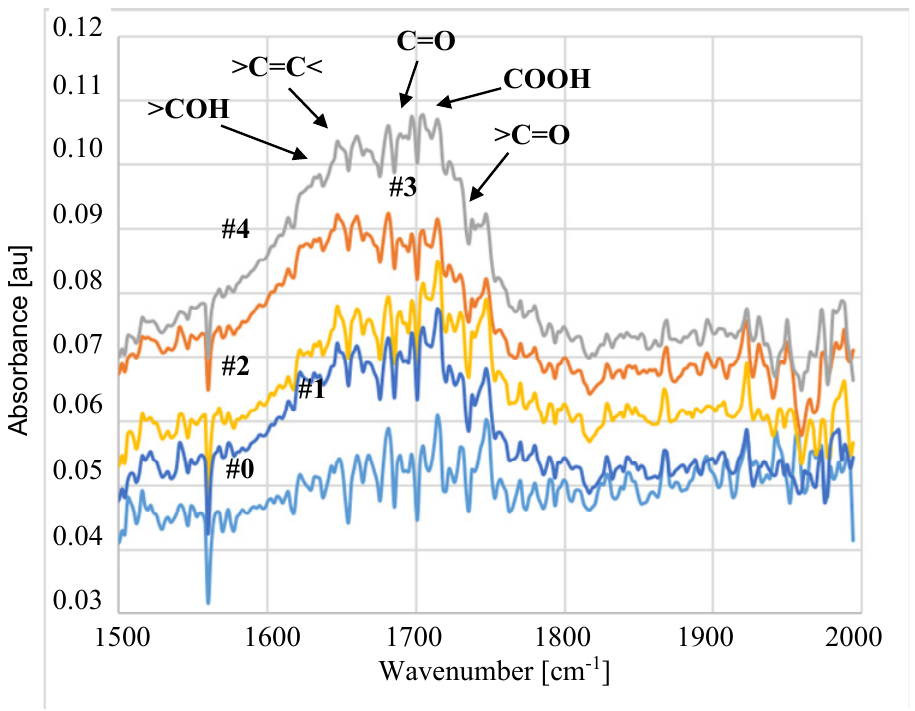
Figure 17. Results of Attenuated Total Reflection-Fourier Transform Infrared Spectroscopy (ATR- FTIR) analyses. Membrane treated by Ar plasma.